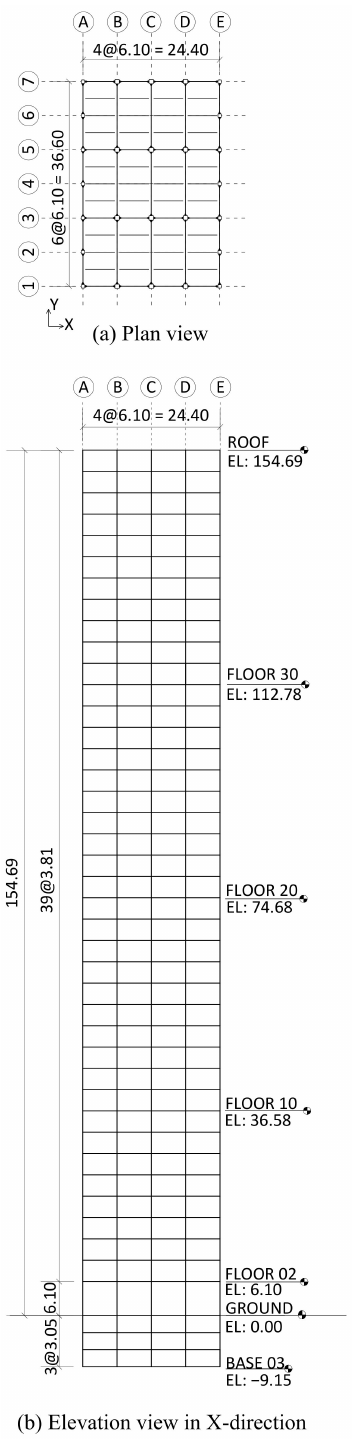
Figure 1. ( a ) Floor plan and ( b ) elevation views of the building, with dimensions in m. In the prototype building, steel beams featured ASTM A36 steel wide flange cross- sections (i.e., nominal yield stress, F y = 248 MPa), and welded box columns. These were typically made of ASTM A36 and/or ASTM A572 Gr. 42 (i.e., nominal yield stress, F y = 290 MPa) steel. The modulus of elasticity of the steel material E was assumed to be 200 GPa in all cases. Material properties for steel components are obtained from Tables 9.1 and 9.3 (1961–1990, Group 1) of ASCE 41-17 [27]. Columns were spliced at every three stories. The column splices were placed at 1.2 m (4 ft) above the respective floor.